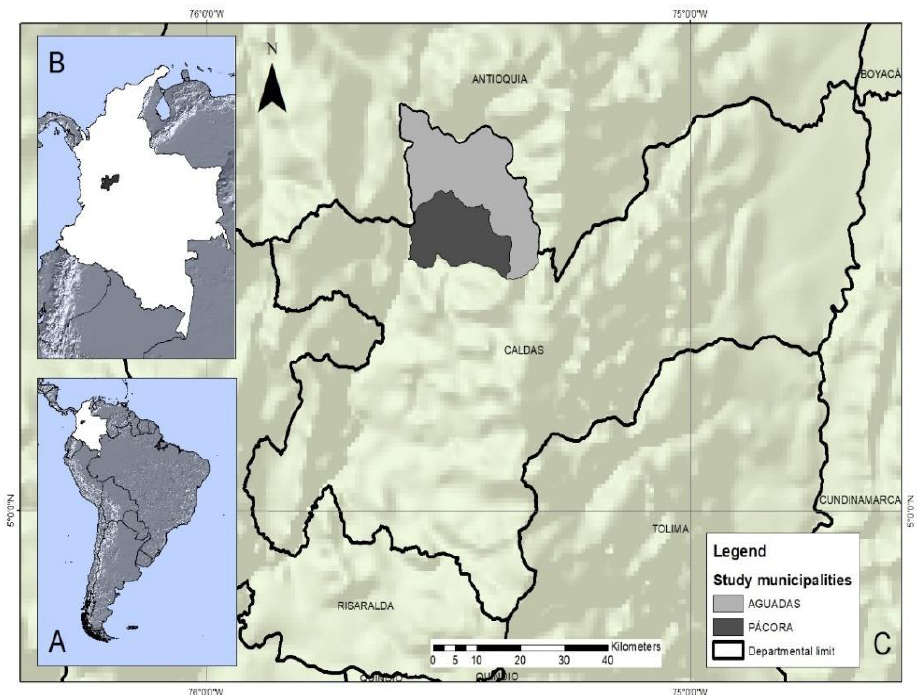
Figure 1. Location of the study area: ( A ) Latin America; ( B ) Colombia and Caldas; ( C ) Aguadas and Pácora.